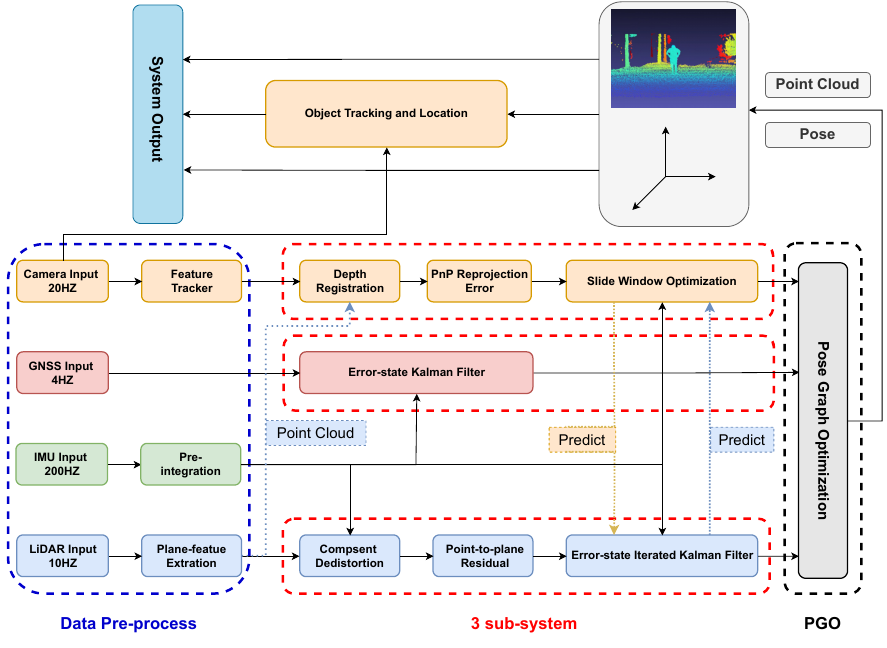
Figure 1. The overview of our system. Target tracking and localization rely on local point cloud maps and poses of keyframes provided by the SLAM system. First, we detect targets on the image, and track them between consecutive frames using a Kalman filter. Subsequently, we filter the point clouds that fall in the detection frame based on the external parameters of the camera and LiDAR, using Euclidean clustering to filter the portion of the closest target as the target point cloud. Laser points may not occupy the ground target within the camera’s field of view because the laser point cloud becomes sparse with increasing distance. Therefore, we consider using a local point cloud map instead of a single frame of laser points as our input to compensate for the sparsity of the laser point cloud. Finally, the real-time global position of the tracked target is calculated based on the key